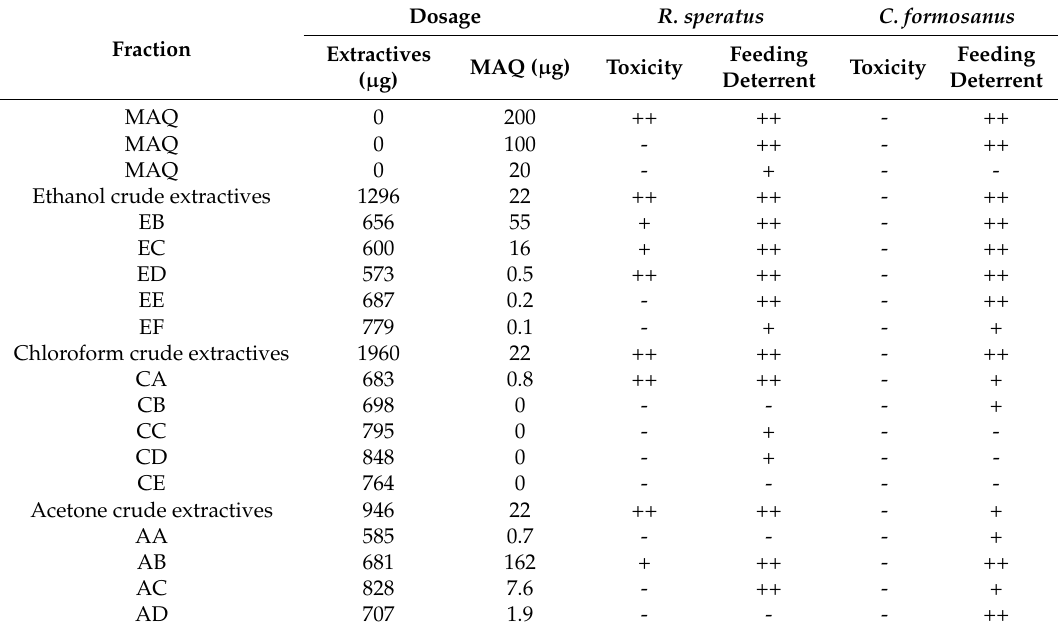
Table 3. Effects of MAQ and T. grandis wood extractives on toxicity and the feeding deterrence against the subterranean termites R. speratus and C. formosanus